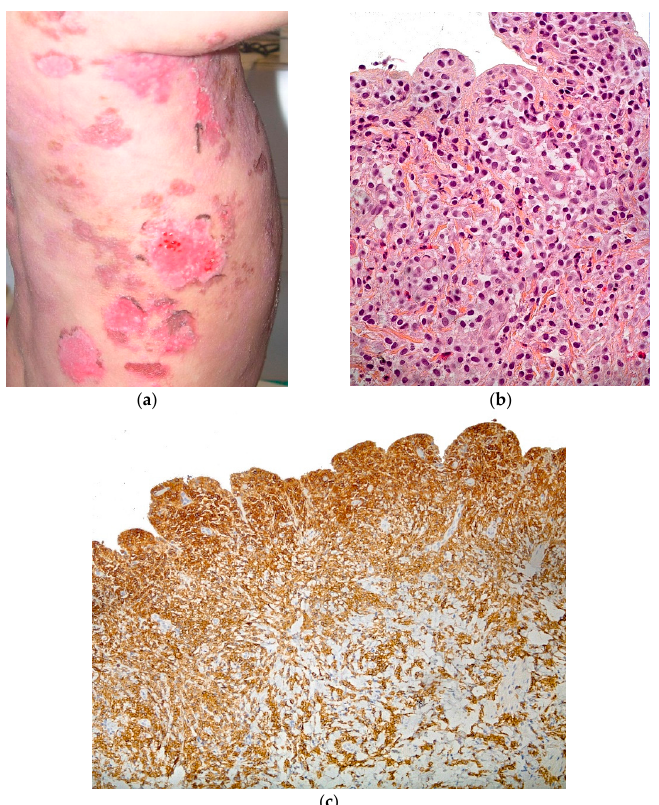
Figure 9. Mastocytosis. ( a ) Generalized blisters. ( b ) Hematein eosin ×40: floor of the blister, conservation of papillary relief, and dense mastocytes infiltrate. ( c ) Immunohistochemistry with anti ‐ CD117 antibody ×10: positivity of the dermal infiltrate.